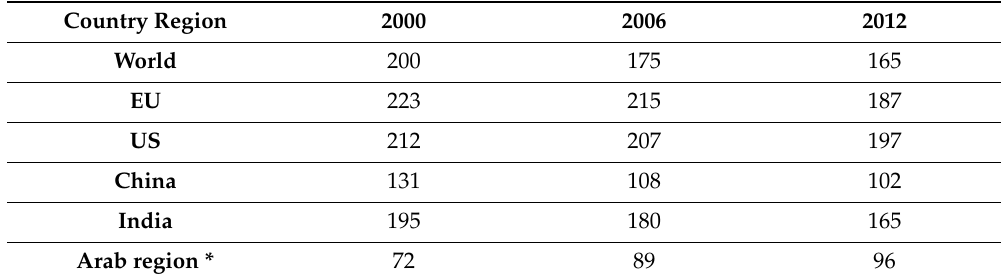
Table 9. Energy use intensity (EUI) (expressed in kWh / m 2 ) for the building sector for Arab region, World, US, EU, China, and India estimated for 2000, 2006, and 2016. Country